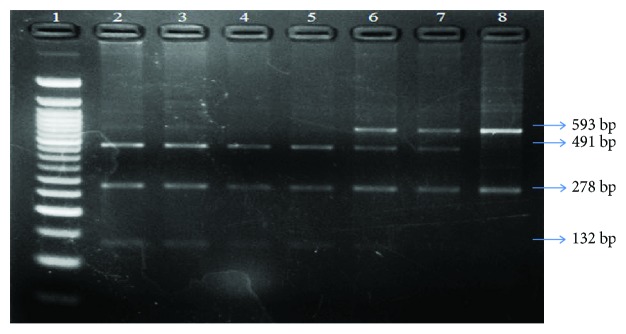
Representative gel picture showing MspI-digested amplicons of XRCC1 codon 399 run on 3% agarose gel. Lane 1: 50 bp DNA ladder. Lanes 2, 3, 4, and 5: 132 bp, 278 bp, and 461 bp Arg/Arg genotype. Lanes 6 and 7: 132 bp, 278 bp, 461 bp, and 593 bp Arg/Gln genotype. Lane 8: 278 bp and 593 bp Gln/Gln genotype.